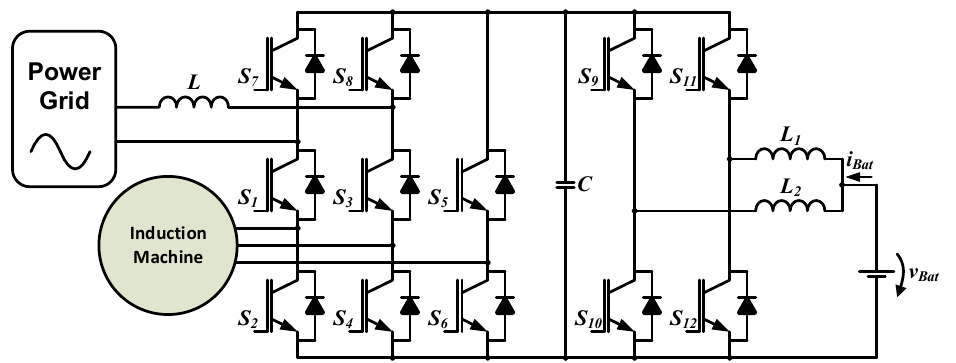
Figure 4. Non-isolated, bidirectional, single-phase unified power converter topology [23].